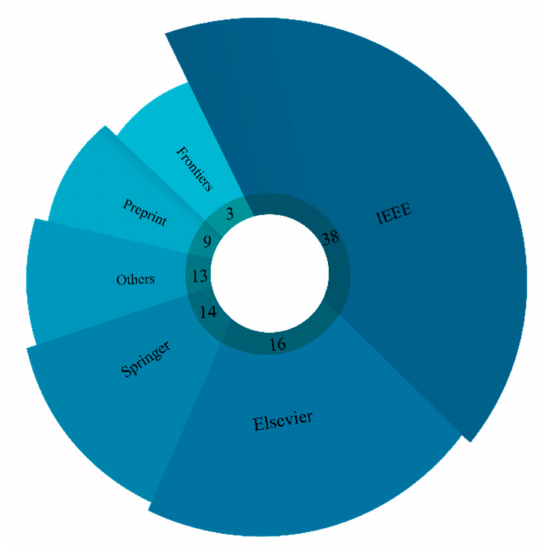
Figure 3. Search strategy